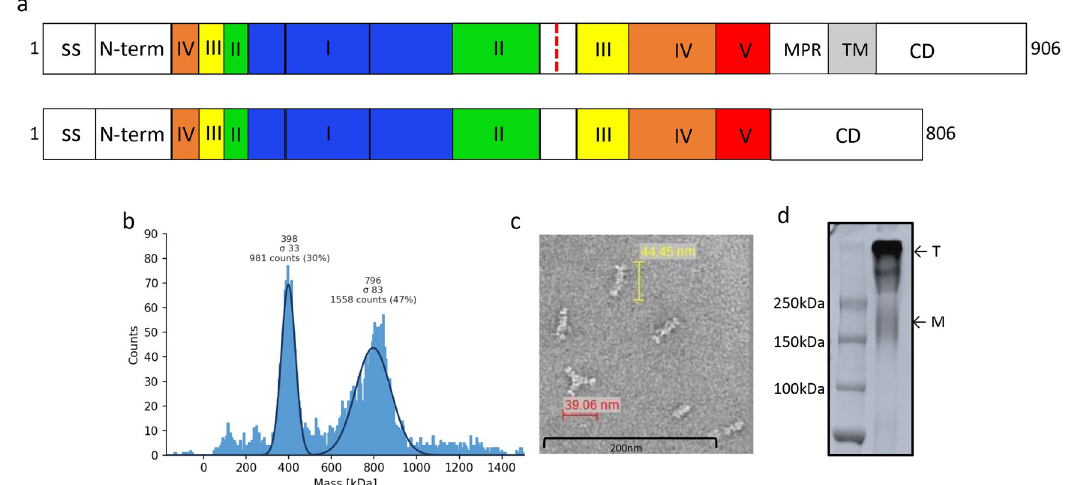
Fig 2. CMV gB protein purification and characterization: (a) Schematic representation of full length and modified CMV gB protein. Antigenic domains (I-V), membrane proximal region (MPR), transmembrane (TM) region and furin cleavage site (as red dotted line) are indicated. The MPR and TM regions were deleted and furin cleavage site was mutated in the gB protein used for vaccine formulation. Schematic representation of gB protein was adapted from Ref. 35 and 36. (b) Mass photometry analysis of CMV gB protein showing trimer and dimer of trimer form of gB protein; molecular weight for trimeric gB was 398 kDa and 796 KDa for dimer of trimer. (c) Negative stain electron micrographs of CMV gB protein representing oligomeric forms of gB protein. Scale bar, 200 nm. (d) SDS-PAGE analysis of purified CMV gB protein under non-reducing condition. Protein migrates as a trimer or dimer of trimer (T). A small fraction of monomer (M) is also visible on SDS-PAGE.